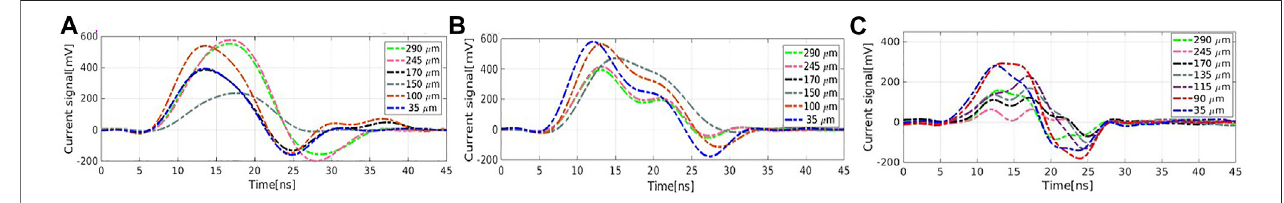
FIGURE 16 | Induced current pulses at varying depths for pixel sensors with Al 2 O 3 + HfO 2 as the dielectric layer irradiated to (A) 10 14 protons/cm 2 , (B) 3 × 10 14 protons/cm 2 , and (C) 10 15 protons/cm 2 are measured at constant temperature of − 15 ° C and bias voltage values of 120 V, 245, and 250 V,